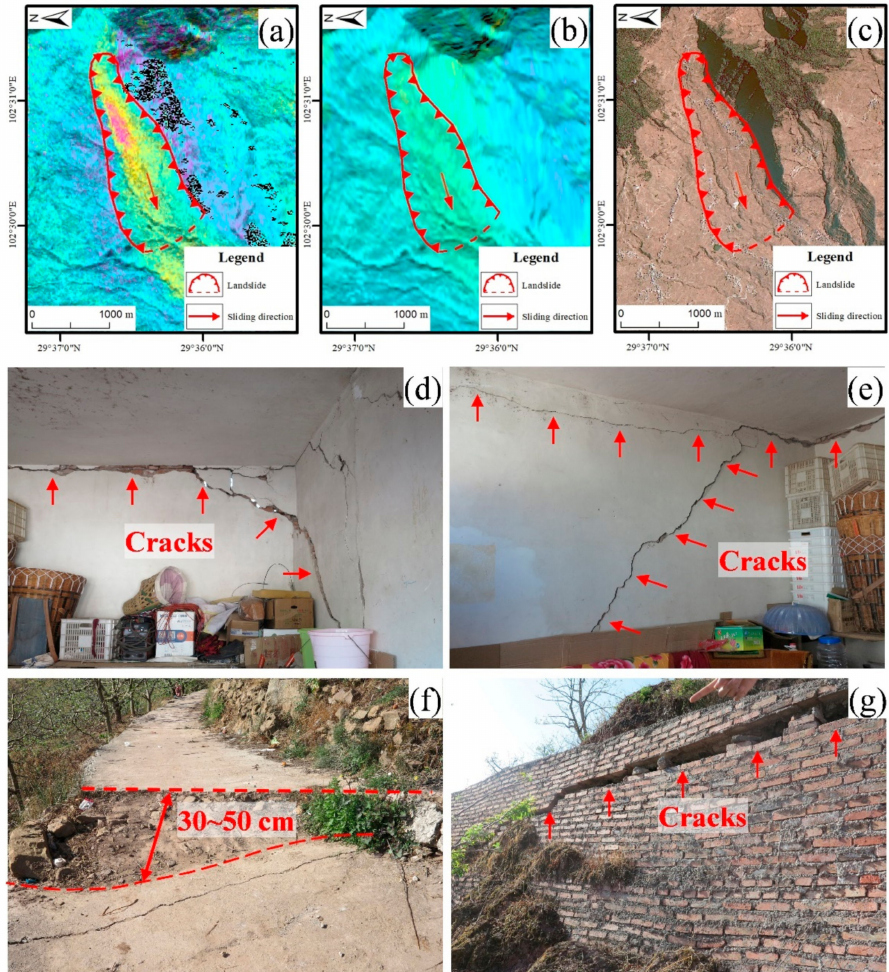
Figure 22. InSAR identification and on-site verification photos of a typical landslide. ( a ) the InSAR result of ALOS-2 data; ( b ) the InSAR result of Sentinel-1 data; ( c ) the optical satellite image of the landslide; ( d – g ) photos showing the deformation characteristics of the landslide. Red arrows in ( d , e , g ) indicate the location of